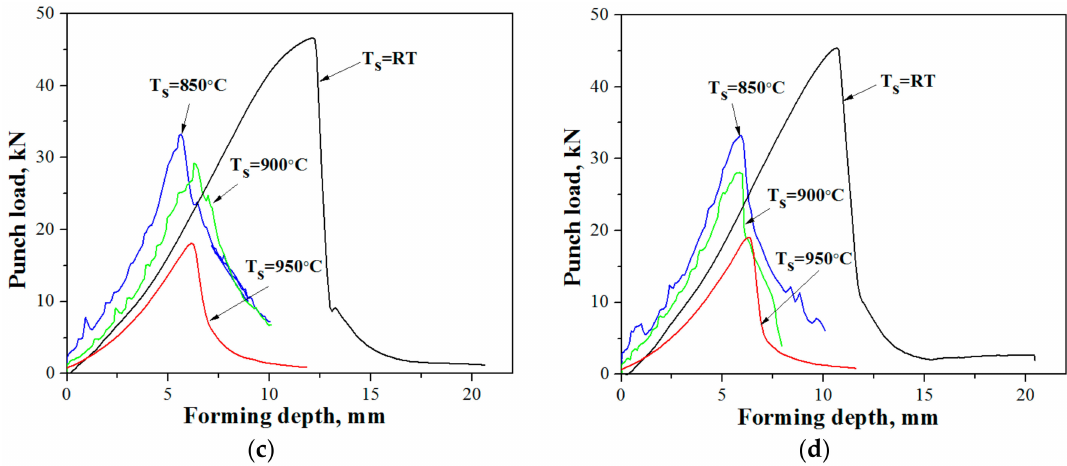
Figure 5. Punch load versus forming depth for indirect ( T s = RT) and direct ( T s = 850, 900 and 950 ◦ C) deep drawing at different blank holding forces: ( a ) B f = 5 kN; ( b ) B f = 15 kN; ( c ) B f = 30 kN; ( d ) B f = 90 kN.